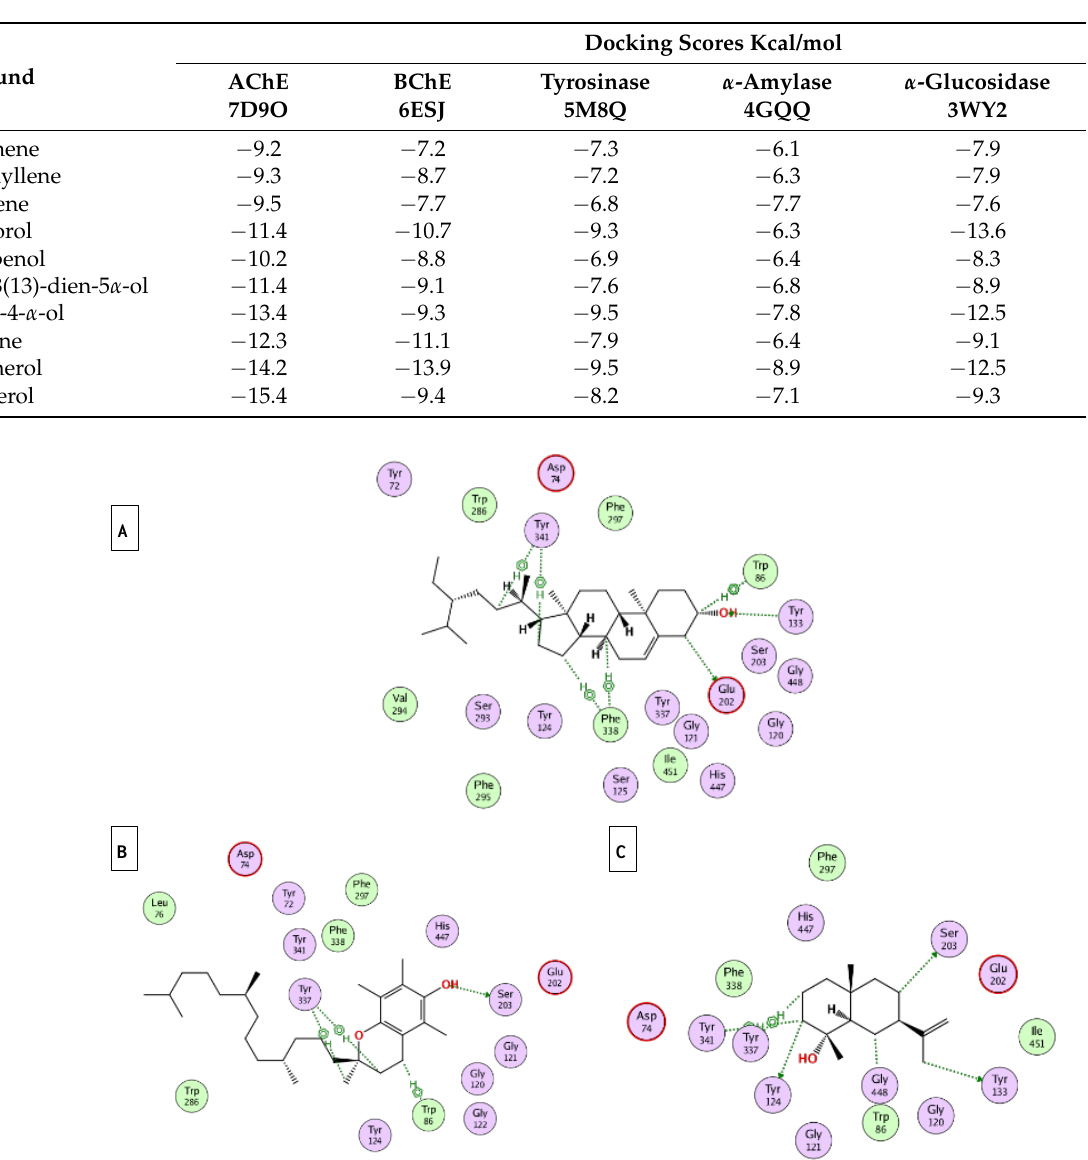
Table 4. The docking scores achieved by the major identified compounds against different enzymes.